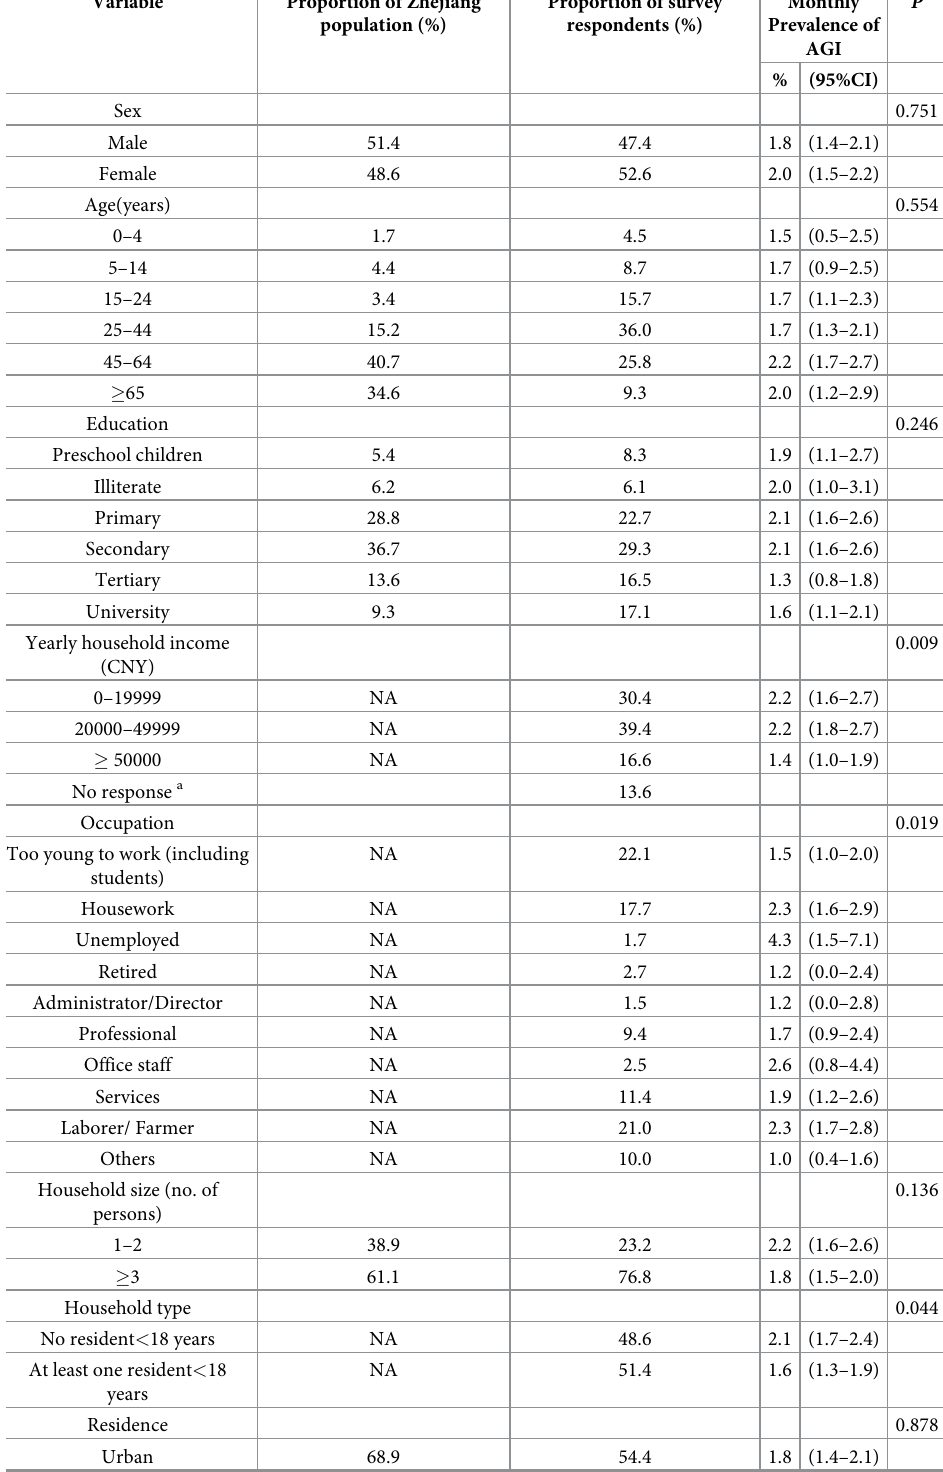
Table 1. Demographic characteristics and weighted monthly prevalence of reported AGI in the 4 weeks prior to interview in Zhejiang Province, July 2018-June 2019 (n =